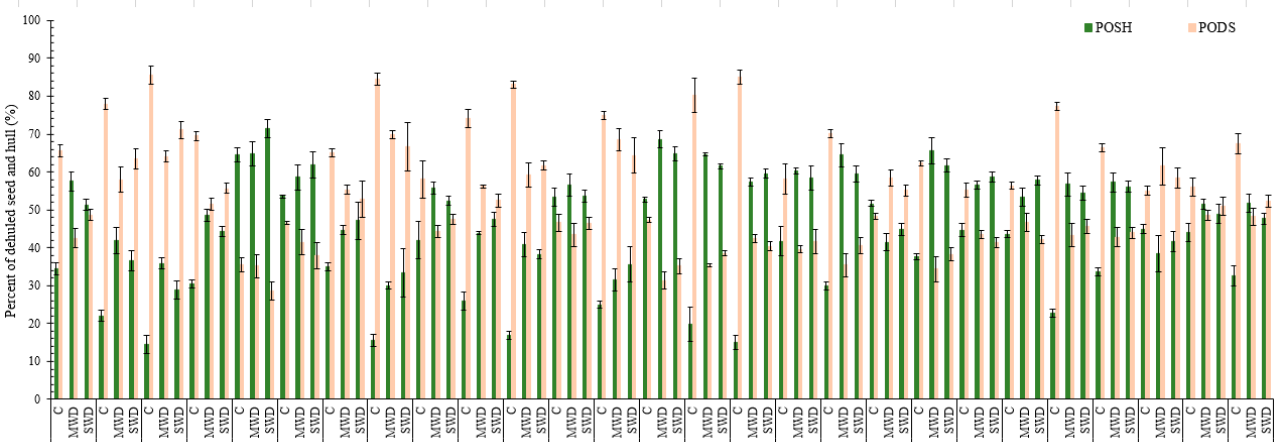
Figure 5. Water treatment (WT) × genotype interaction effect on the percent of seed hulls (POSH) and percent of dehulled seed (PODS). C: control; MWD: moderate water deficit; SWD: severe water deficit. L 1 –L 3 : 3 testers, G 1 –G 6 : 6 male parents;